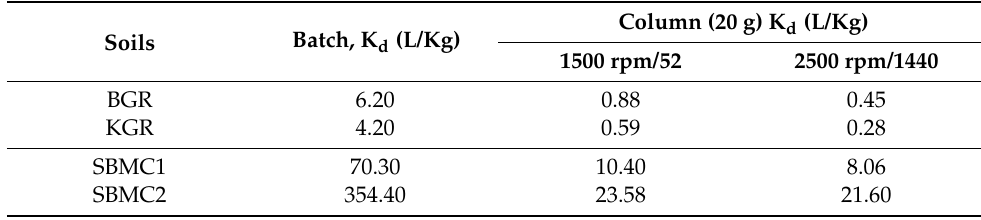
Table 4. Partition coefficient (K d ) of soils from centrifuge column testing.